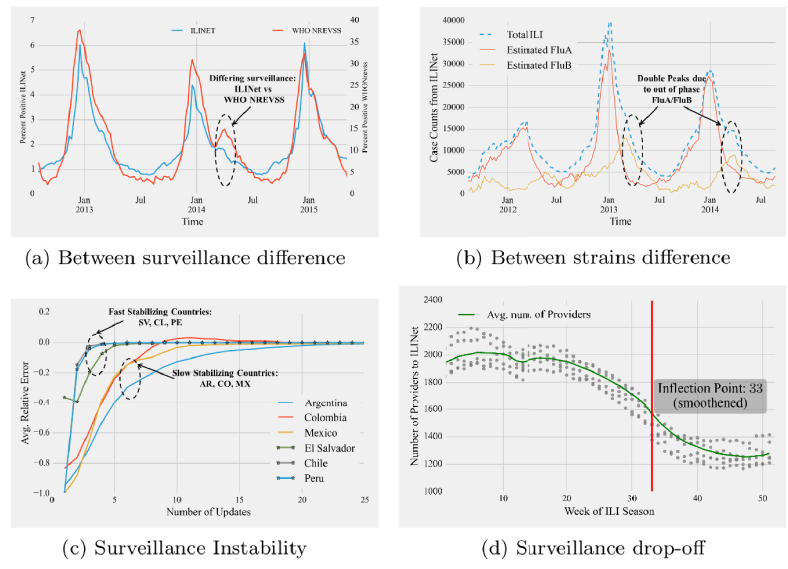
Fig 1. Surveillance characteristics. Data range 2012–2015. (a) Lag between reported ILI percentage curves as reported by two surveillance systems (ILINet versus WHO NREVSS) in the US, (b) Lag between ILI substrain reports at national level (Flu A vs Flu B) leading to double peaked overall ILI curve in the US, (c) Surveillance reports are revised many weeks after first report. While countries like Chile stabilizes quickly (within 5 weeks), other countries like Argentina stabilizes after many weeks ( � 10). (d) Surveillance drop-off towards the end of the season—scatter plot of number of providers reporting to CDC ILINet as a function of ILI season week. Green Line shows the smoothened average while the red vertical line shows the smoothened inflection point of surveillance coverage. (Smoothing interval = 4) CDC, Centers for Disease Control and Prevention; ILI, Influenza-like Illnesses; NREVSS, National Respiratory and Enteric Virus Surveillance